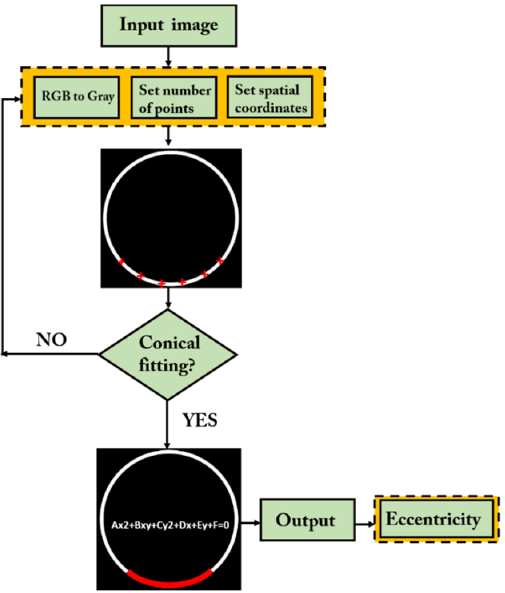
Figure 2. Schematic diagram of the proposed segmentation algorithm.